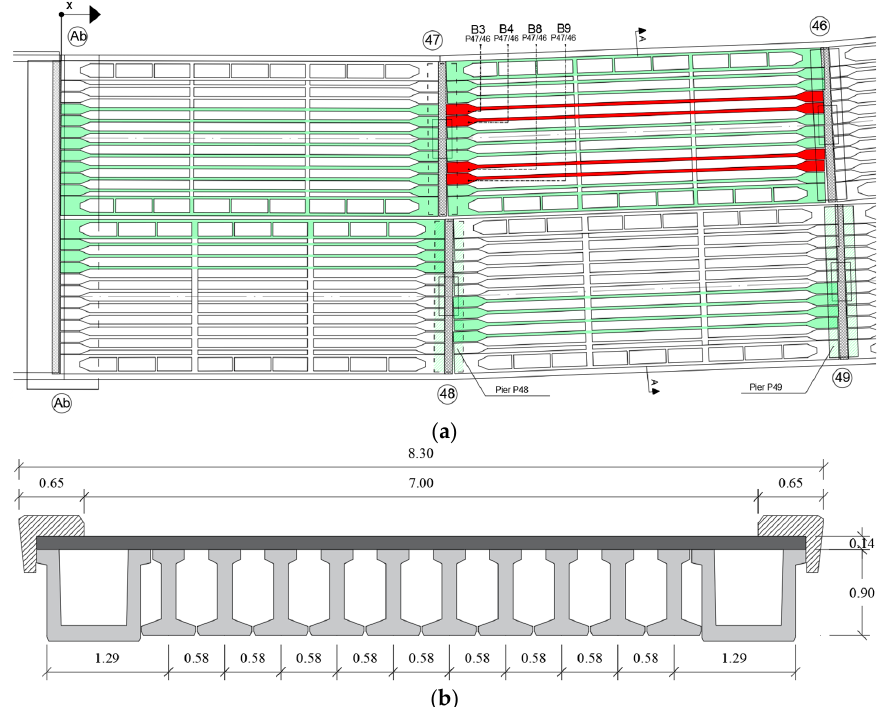
Figure 2. ( a )Top view; ( b ) cross-section of the PC deck (in meters). The girders had an average span length of 19.2 m. According to the design documen- tation [26], the girders were pretensioned using 17 strands along the bottom flange, dis- tributed on two rows, and 3 strands on the top flange with a nominal diameter of 12.7 mm, as reported in Figure 3. In the bottom flange, three strands from 0 to 5 m and two from 0 to 3 m starting from the end sections were unbonded using ducts. The shear rein- forcement consisted of ∅ 8 mm stirrups with 250 mm spacing. The stirrups were also used to connect the precast beam with the cast in situ top deck slab.